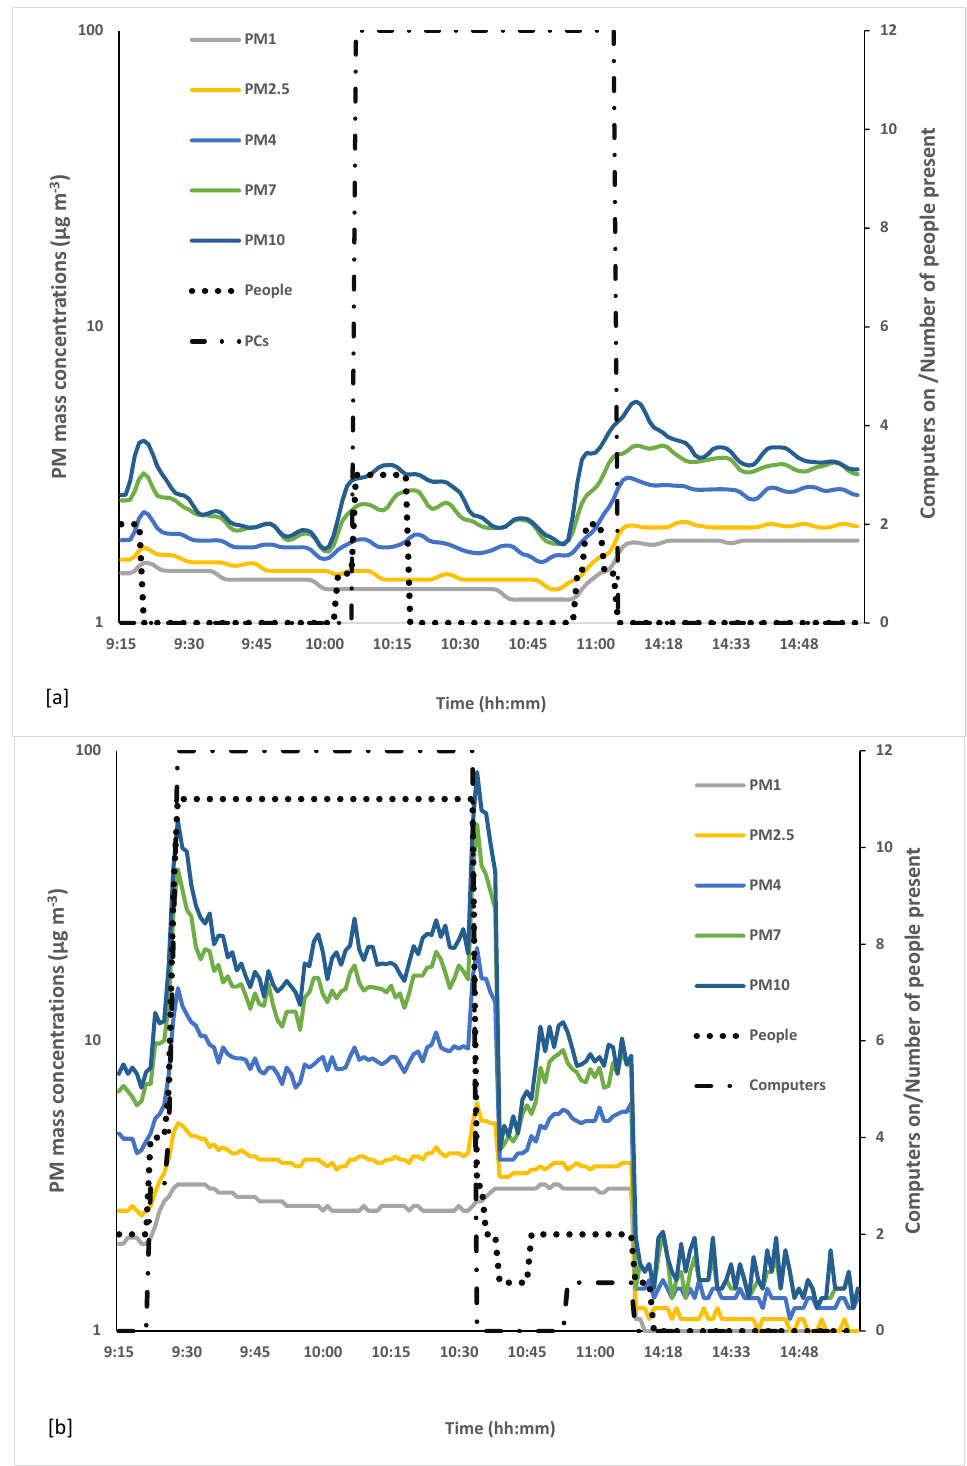
Figure 2. (a , b) Campaign 1, Office and Lab: PM mass concentrations, number of people present, and number of operating PCs (inside the Lab).